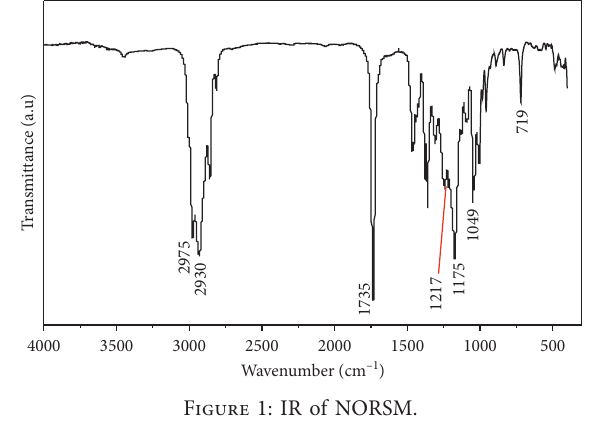
Figure 1: IR of NORSM.